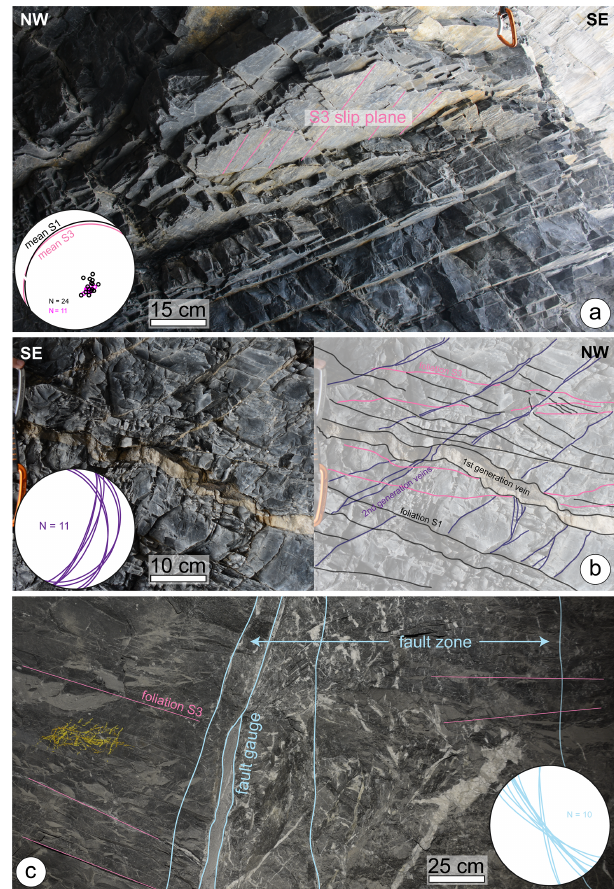
Figure 4. Bedrock fabric and discontinuity network at sample sites EM-01 and EM-02 at the SE sides. (a) Bedrock at current surface close to EM-01 highlighting the weathering paths along pre-existing weaknesses. (b) Details of the bedrock fabric at site EM-02 with structural interpretation in the right panel. (c) Fault zone near the sampling sites that deeply penetrate the Eiger (based on Appendix image from Mair et al., 2018). Structural orientation data partly based on Mair et al.